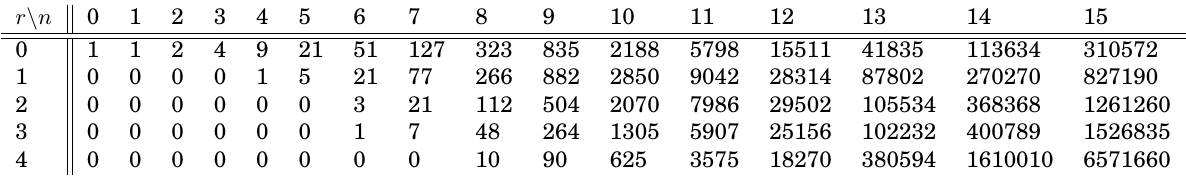
Table 2: Number of involutions in I n,r , where 0 ≤ n ≤ 15 and 0 ≤ r ≤ 4 .